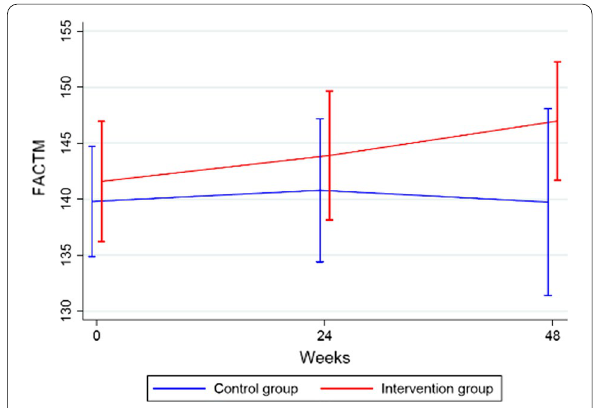
Fig. 3 FACT-M data for patients in the PROMelanoma study at baseline, week 24 and week 48, comparing the HRQoL between patients assigned to the ePRO intervention and patients who received standard care